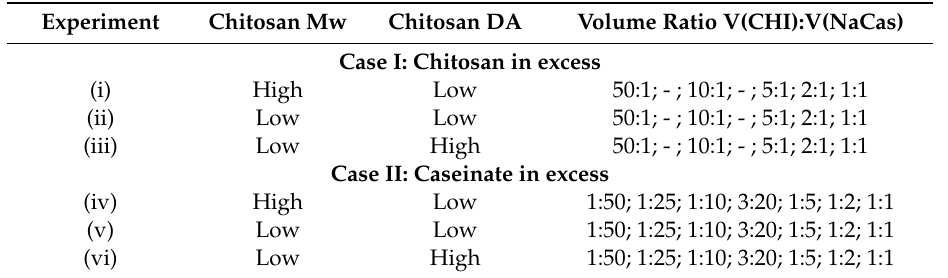
Table 2. Summary of the di ff erent formulations considered by varying processing parameters in the di ff erent experiments of the Cases I and